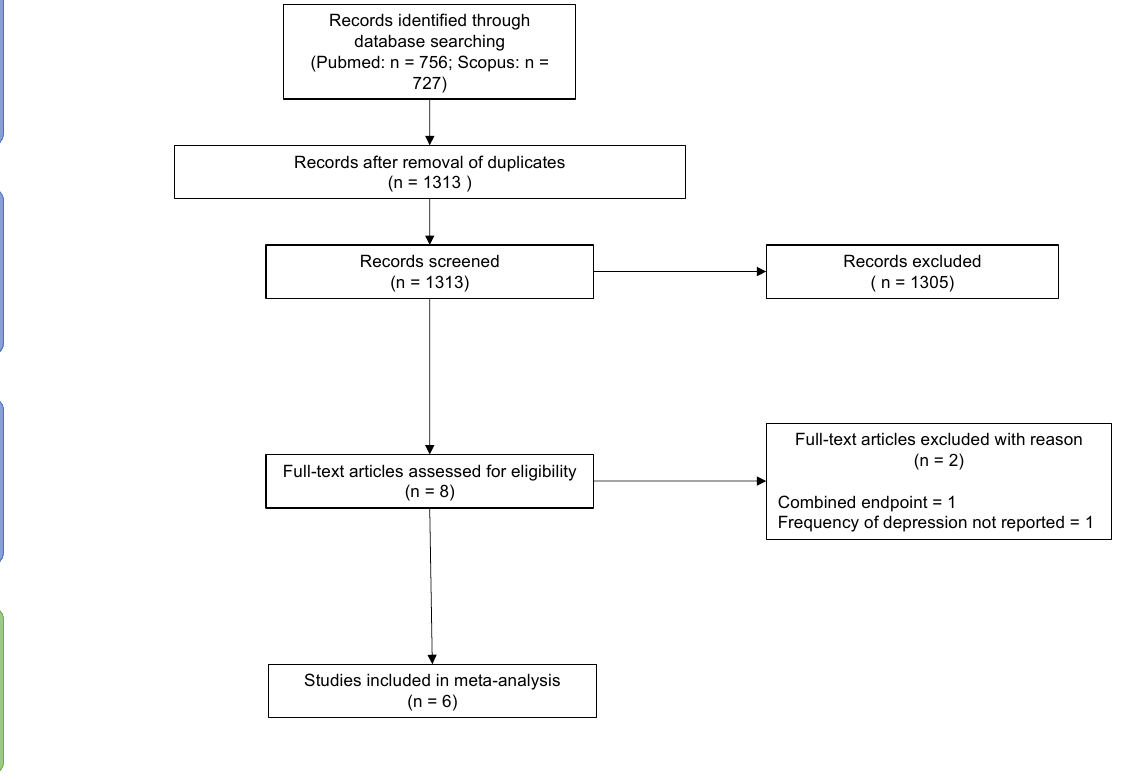
Figure 1. Study selection process.